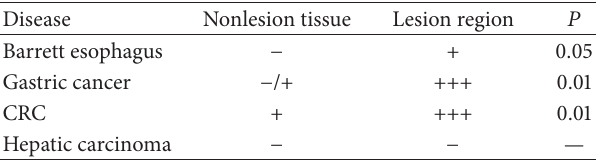
Table 3: Immunohistochemical staining